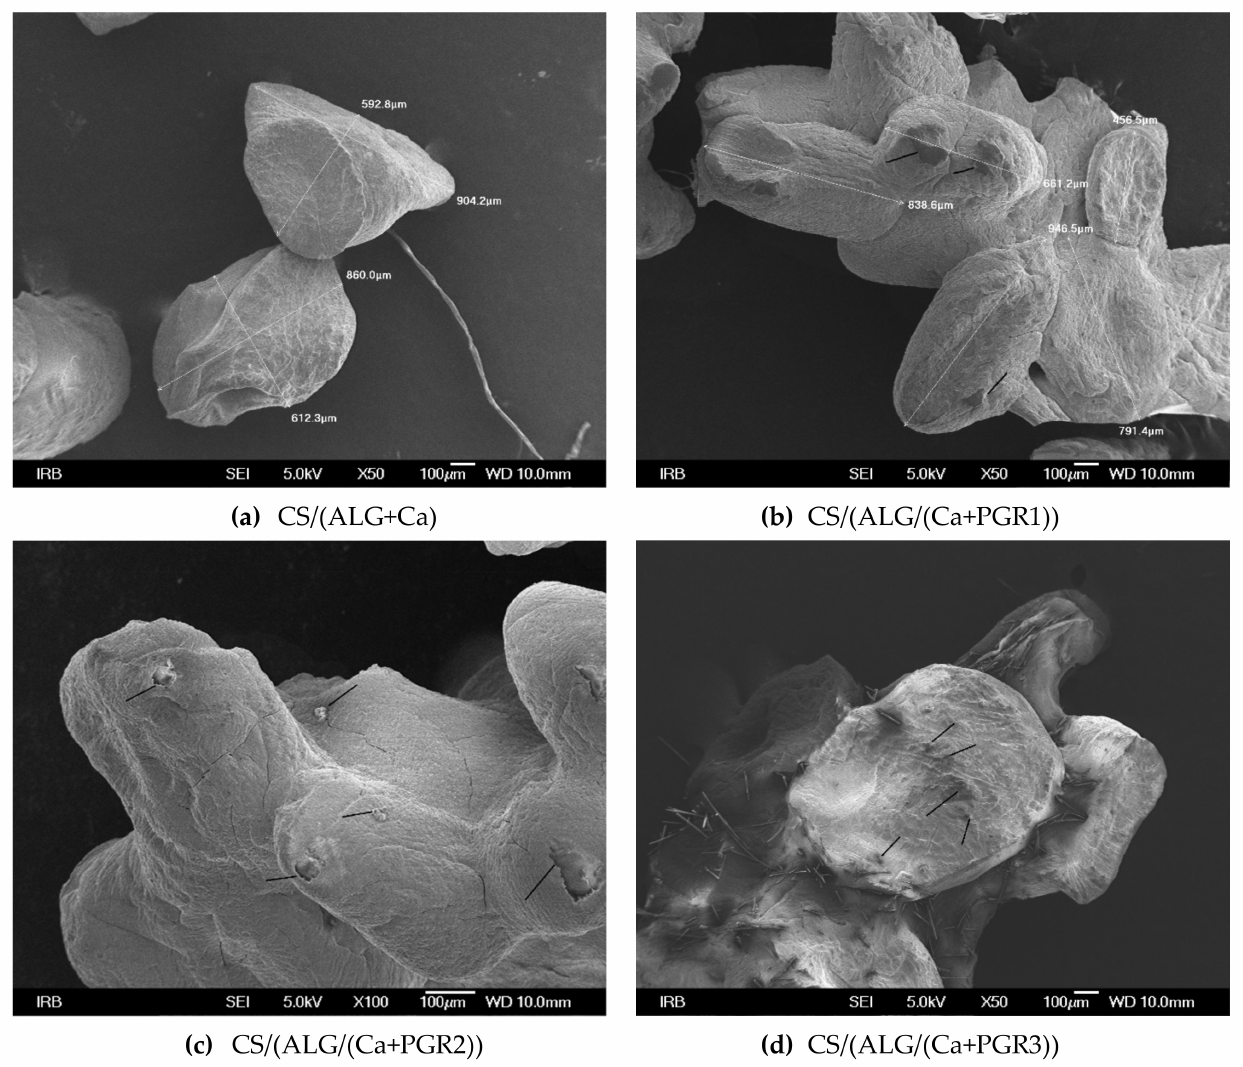
Figure 3. SEM microphotographs of dry microcapsule formulations (as denoted). Microcapsules were prepared without ( a ) and with PGR1 ( b ), PGR2 ( c ) and PGR3 ( d ). Aggregated nubs are marked by black lines ( c , d ). Bars are